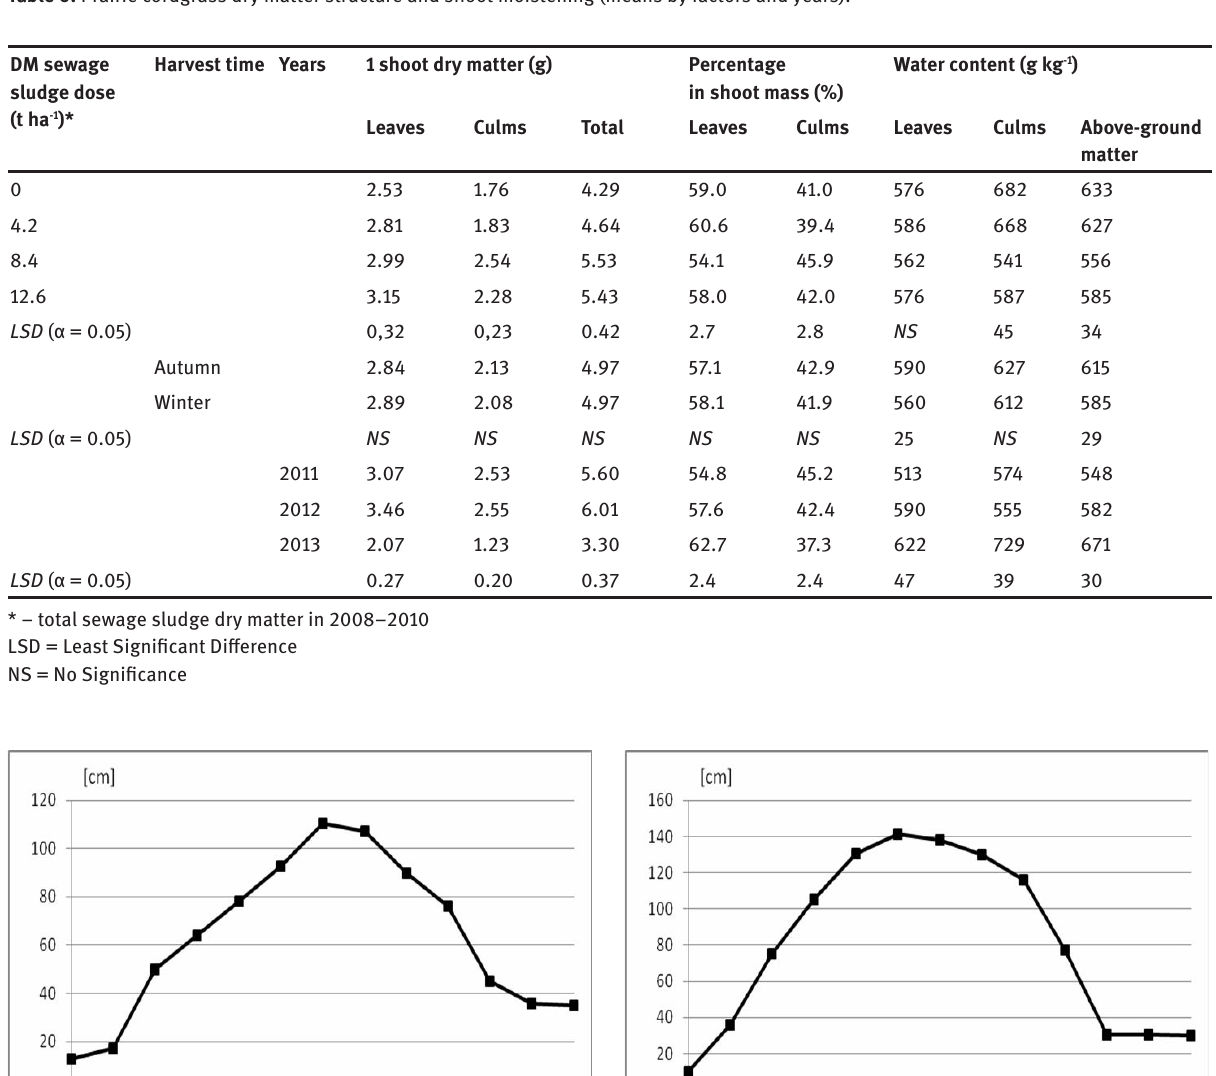
Table 6: Prairie cordgrass dry matter structure and shoot moistening (means by factors and years).